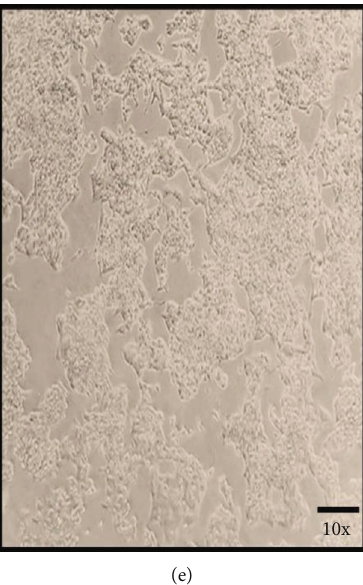
Figure 2: HepG2 cells were treated with probiotic V and Met alone or together as probiotic V and Met treatment in the presence of ethanol for 48 h. Microscopic images of HepG2 cells treated with (a) control, (b) 100 mM ethanol control, (c) 100mM ethanol+10 μ l/ml probiotic V, (d) 100 mM ethanol+1 mM Met, and (e) 100 mM ethanol+10 μ l/ml probiotic V and 1 mM Met combination. The above fi gures are